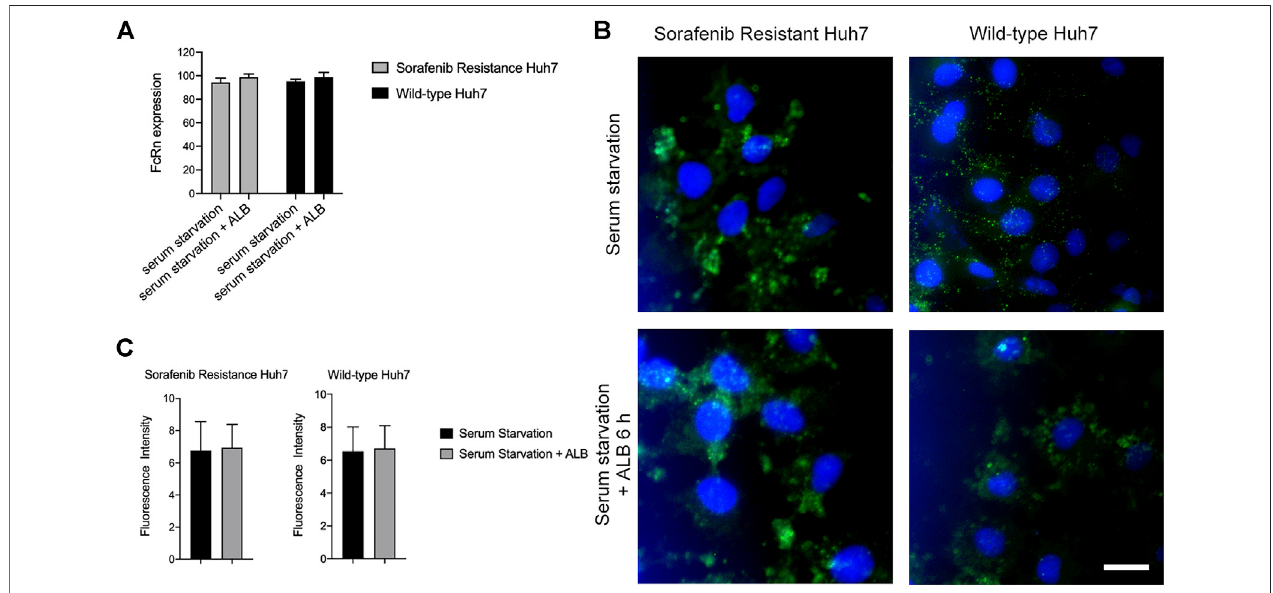
FIGURE 5 | The expression of FcRn in huh7 (SR) and huh7 (WT). (A) FcRn expression of Huh7 (SR) and Huh7 (WT) cells in serum starvation 6 h and adding ALB after serum starvation 6 h, as determined by fl ow cytometry. (B-C) FcRn expression (green) of Huh7 (SR) and Huh7 (WT) cells in serum starvation 6 h and adding ALB after serum starvation 6 h, as determined by Immuno fl uorescence. Cell nuclei were dyed by Hoechst (blue). Scale bar: 10 μ